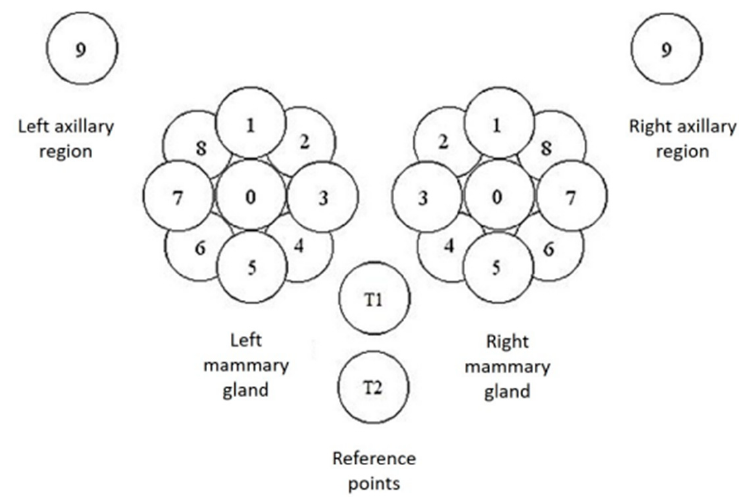
Figure 3. Capture positions for each mammary gland (0–8) and at the axillary point (9). There are additional T1 and T2 reference points under the chest. Each position was captured on the skin and at a depth of 3–5 cm.